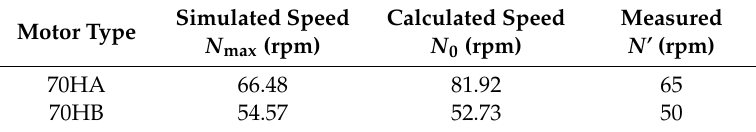
Table 4. Results of maximum speed by simulation, calculation, and measurement. Table 5. Results of maximum stall torque by calculation and